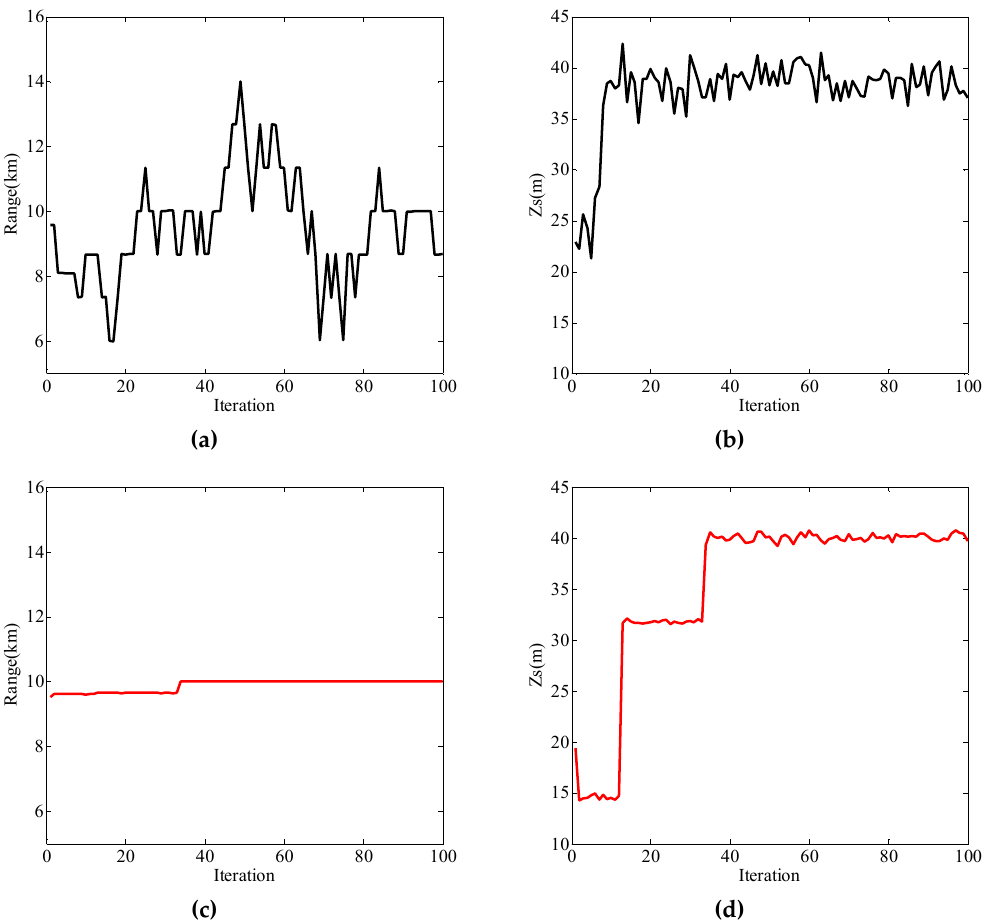
Figure 8. Localization results for the measured vector as the pressure (black line) and the vertical wave impedance (red line). ( a ) Range estimation result with pressure as the measured vector; ( b ) source depth estimation result with pressure as the measured vector; ( c ) range estimation result with vertical wave impedance as the measured vector; ( d ) source depth estimation result with vertical wave impedance as the measured vector.